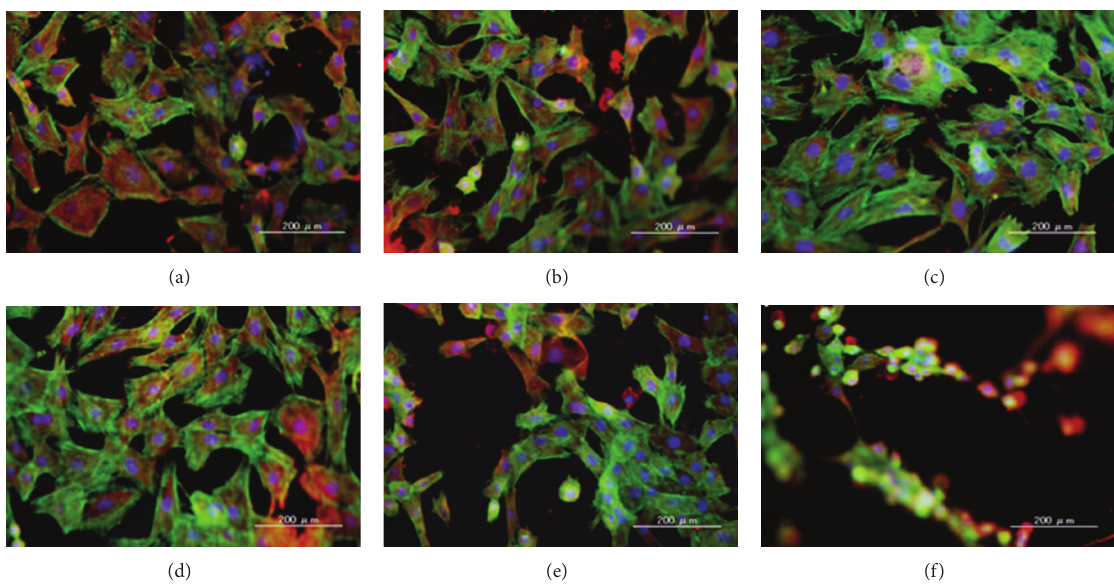
Figure 5: Morphology of RAOSMC on the pure Co-Cr alloy plate (a–c) and the photofunctional Co-Cr alloy plate (d–f) without laser irradiation (a, d) and with laser irradiation for 15 min (b, e) and 30min (c, f) of 15mW/cm 2 ( 𝜆 cytoskeleton, plasma membrane, and nuclei, respectively. Magnification was